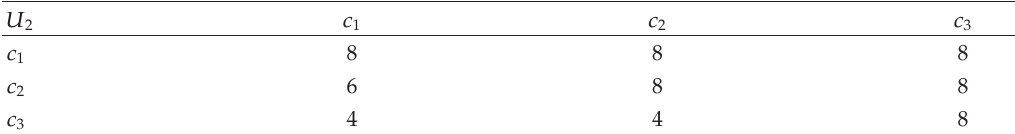
2 -fuzzy soft multiset part of of